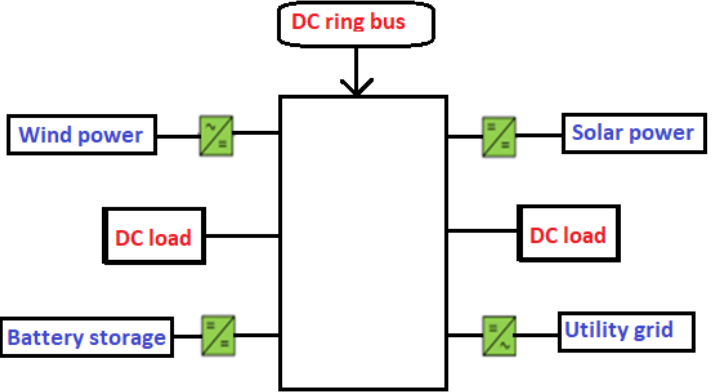
Figure 1. A typical ring-main topology of a DCMG.